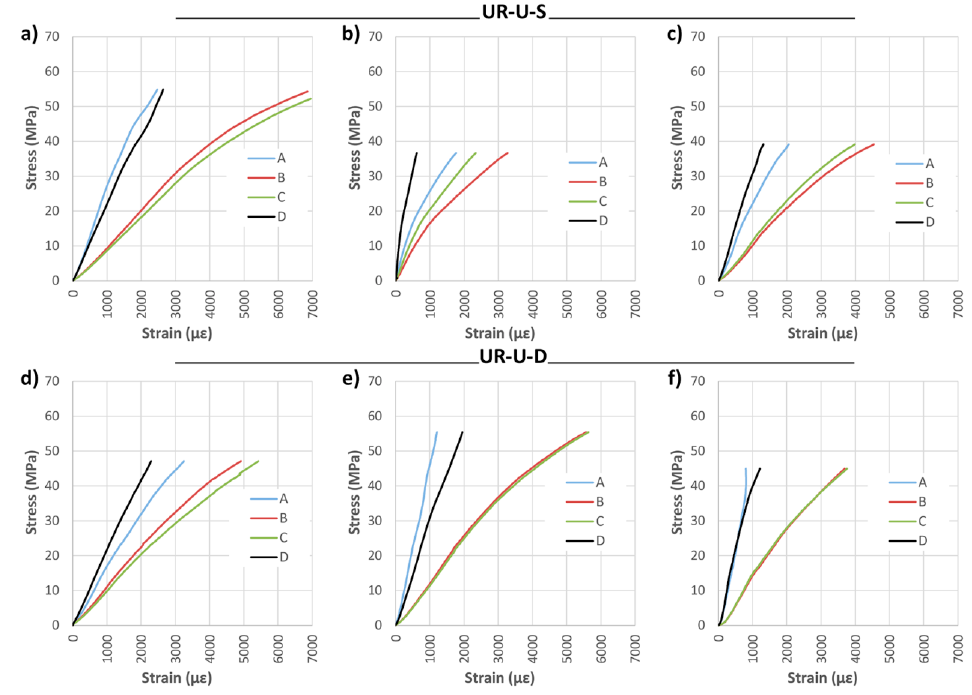
Materials 2017 , 10 , 1113 15 of 21 Figure 16. Stress against strain during bending tests: ( a ) UR-U-S-1; ( b ) UR-U-S-2; ( c ) UR-U-S-3; (d) UR-U-D-1; ( e ) UR-U-D-2; and ( f ) UR-U-D-3. CFRP suppliers: SIKA ® and DRIZORO ® .